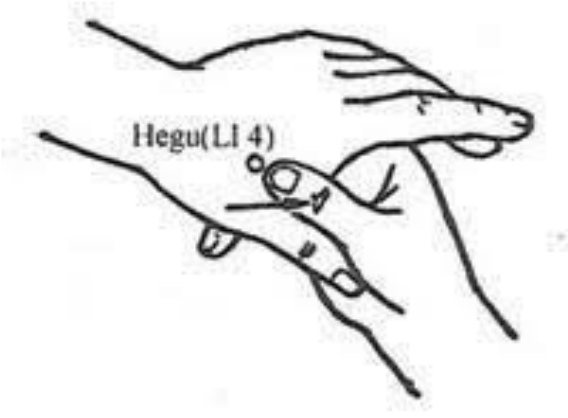
Figure 1. Hegu LI 4 Pressure